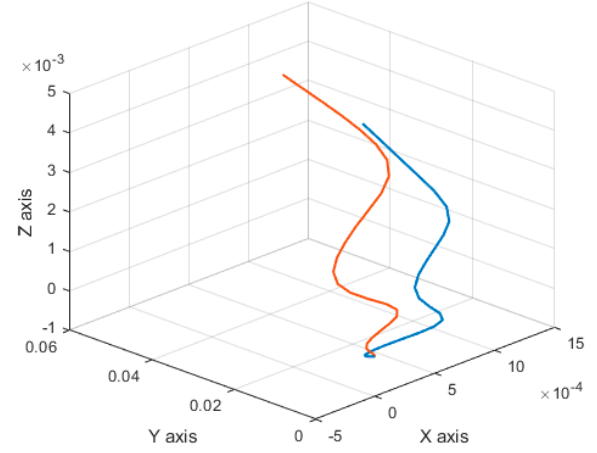
Figure 9. Three-dimensional (3D) trajectories diagram of VWM and fVWM.